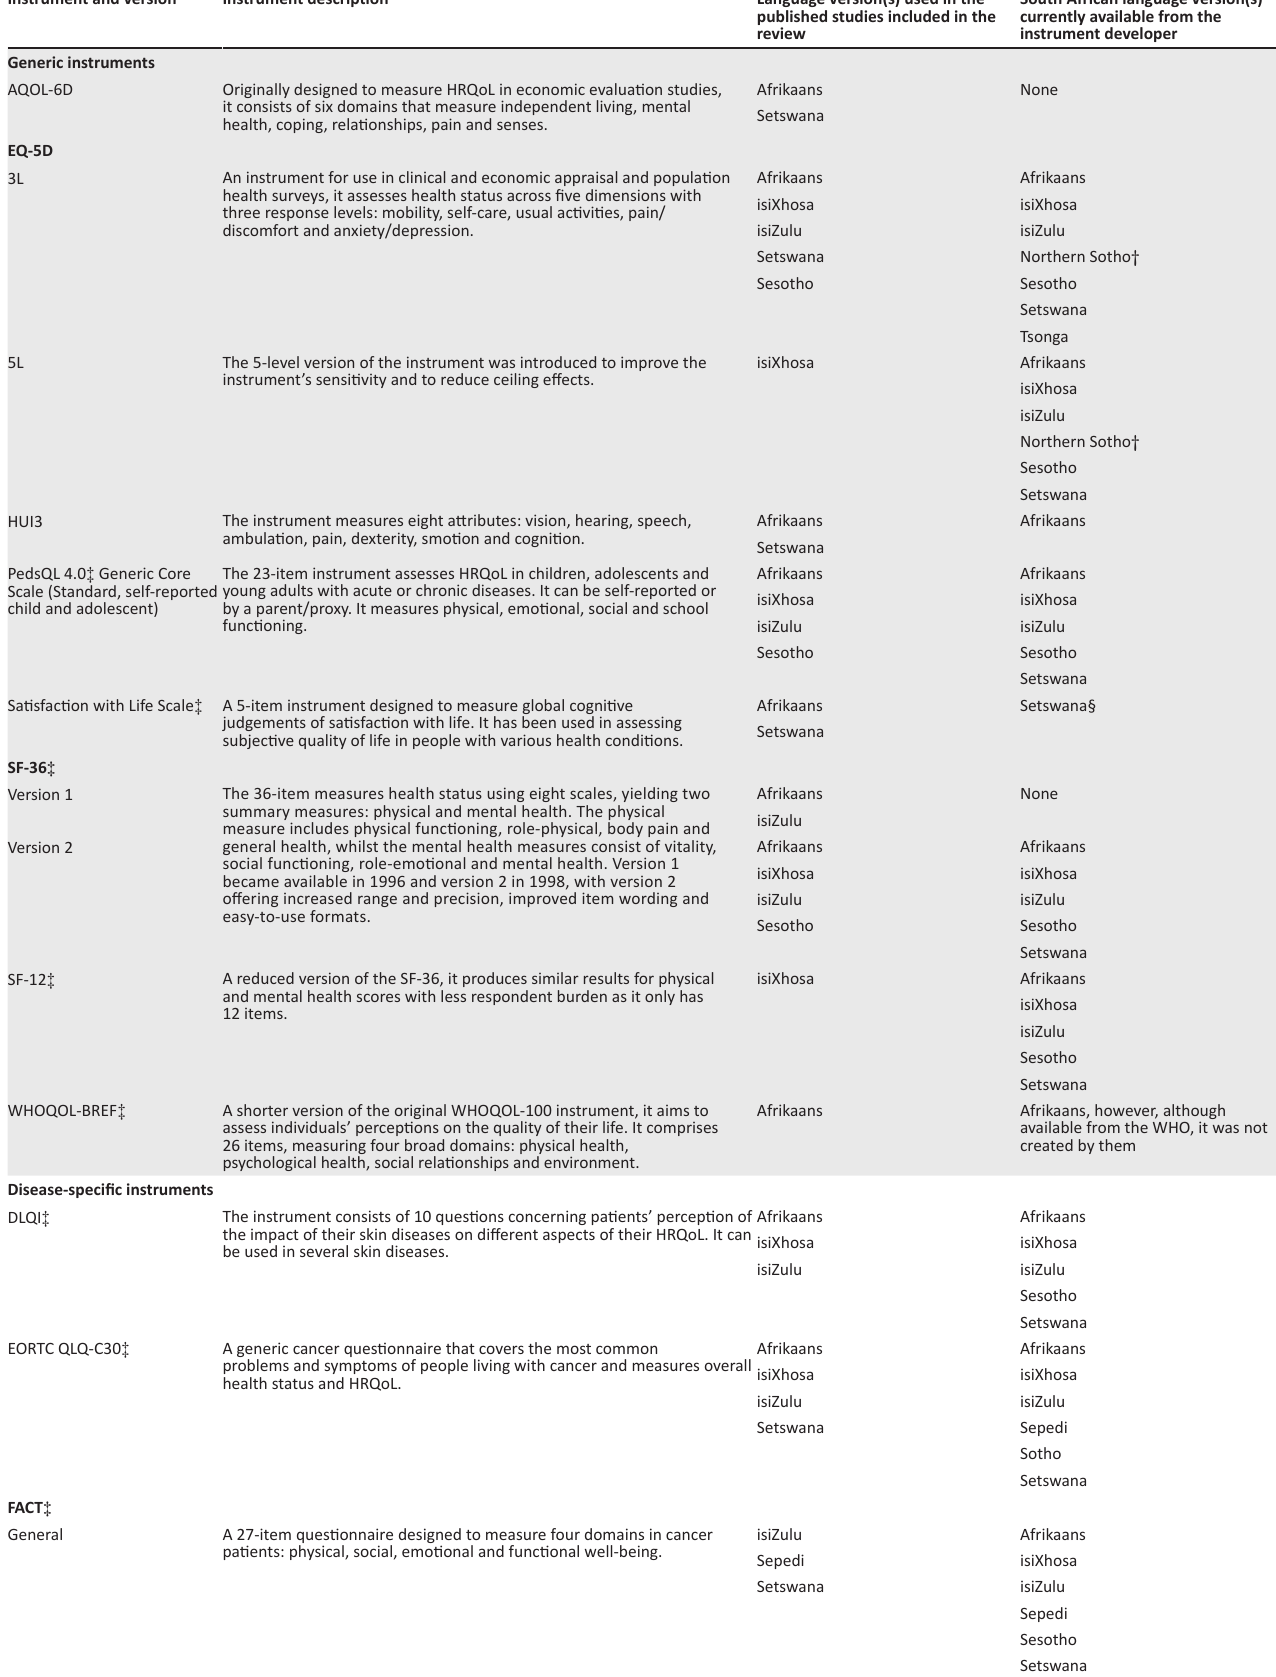
TABLE 2: Translated health-related quality of life instruments that have been used in South